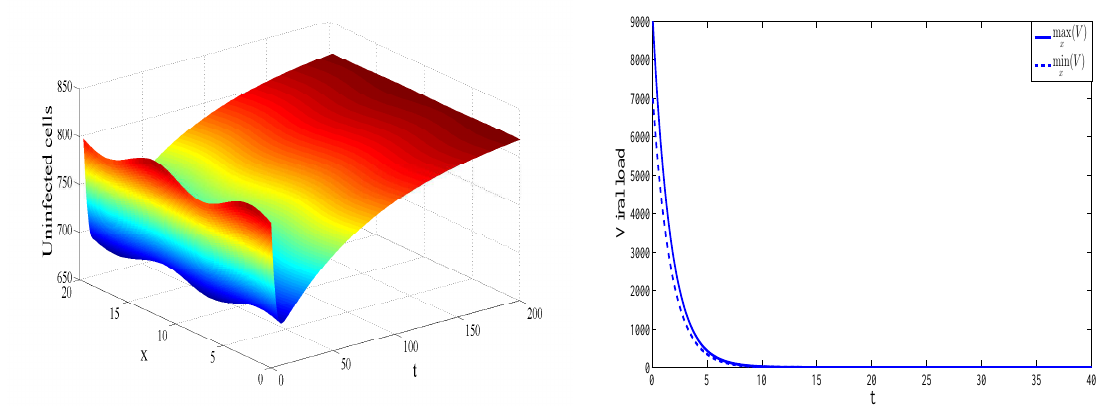
Figure 1. Dynamics of solution for λ = 10, d 1 = 0.0139, k 1 = 0.04, d 2 = 0.0495, k 2 = 1.1, d 3 = 0.5776, a = 2, d 4 = 0.6, p = 0.0024, c = 0.15, and b = 0.5. The concentration of uninfected cells is shown as a function of x and t ( left ). The maximal and the minimal value of the virus concentration with respect to x are shown as functions of time ( right